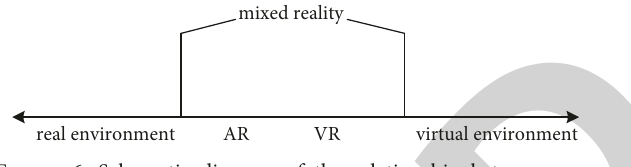
Figure 6: Schematic diagram of the relationship between aug- mented reality and virtual